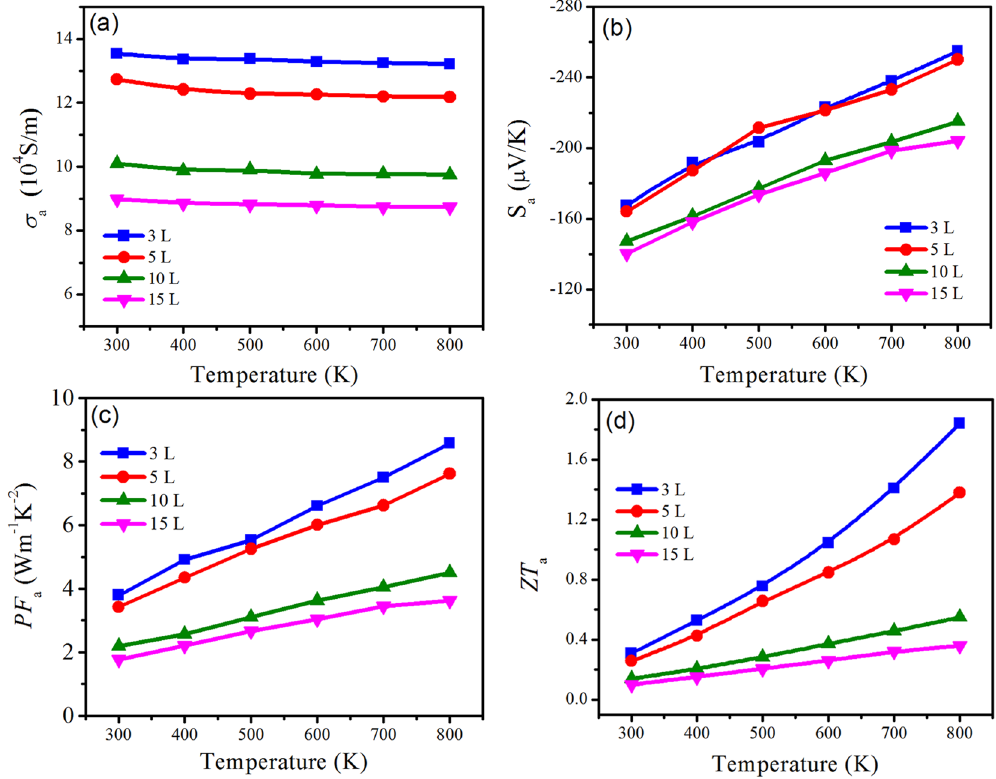
Figure 6. Electrical conductivity ( a ), Seebeck coefficient ( b ), power factor ( c ), ZT ( d ) of SnS 2 sheets along a-b plane for 3 L, 5 L, 10 L, 15 L as functions of evaluated temperature at optimal carrier